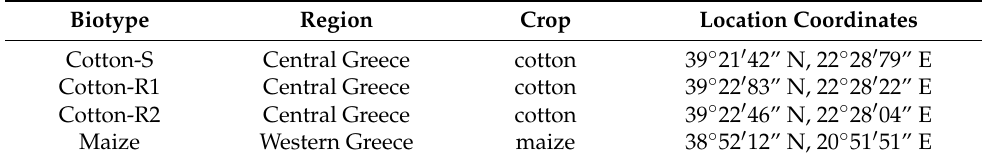
Table 2. Palmer amaranth biotypes location in